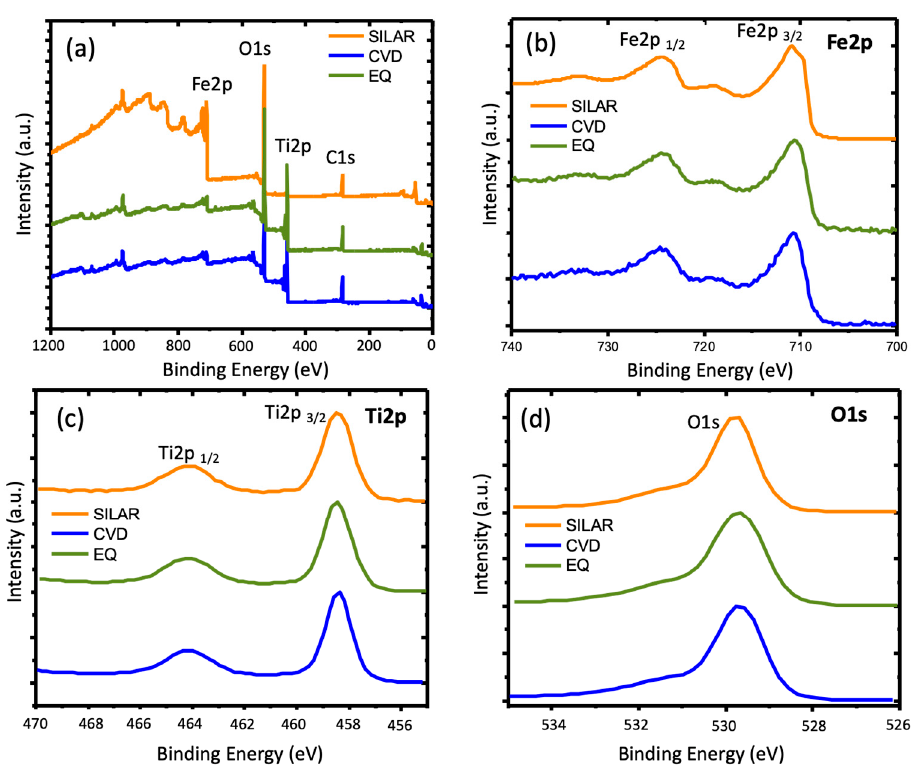
Figure 7. TiO 2 nanotubes modified with hematite. ( a ) Survey spectrum, ( b ) Fe2p, ( c ) Ti2p, and ( d ) O1s of synthesized materials’ nt-TiO 2 / α -Fe 2 O 3 using SILAR, CVD, and EQ as synthetic methods.